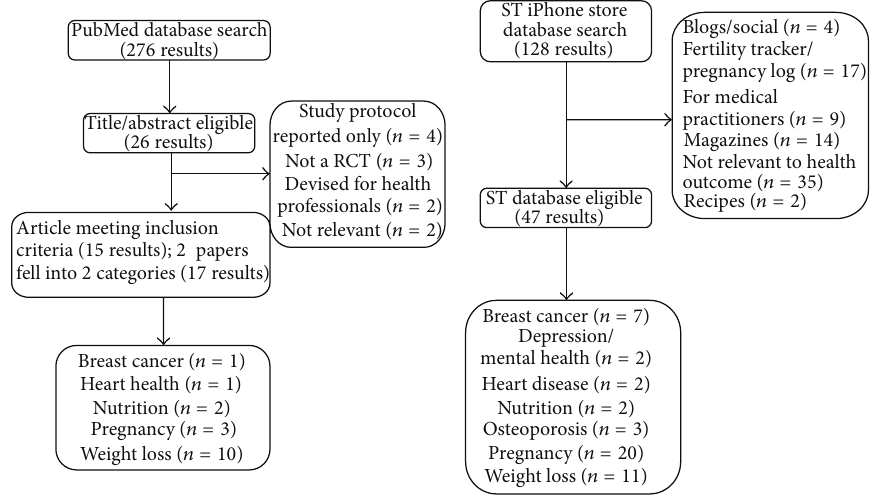
Figure 1: Methodology procedures for Medline, Web of Knowledge, and iPhone store database